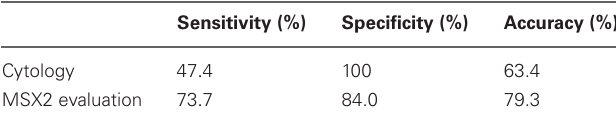
Table 5 | Comparison between cytology and MSX2 measurement in brush samples (Satoh et al., 2011).